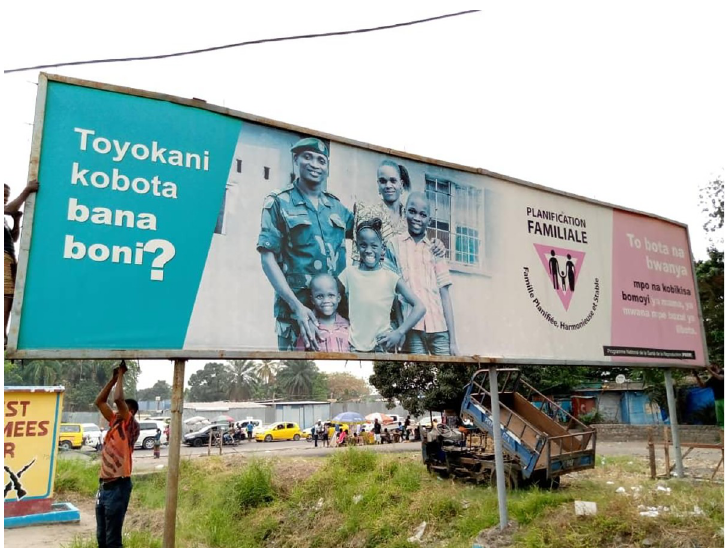
Fig 1. Family planning billboard depicting military personnel, located outside the military camp in Kinshasa,